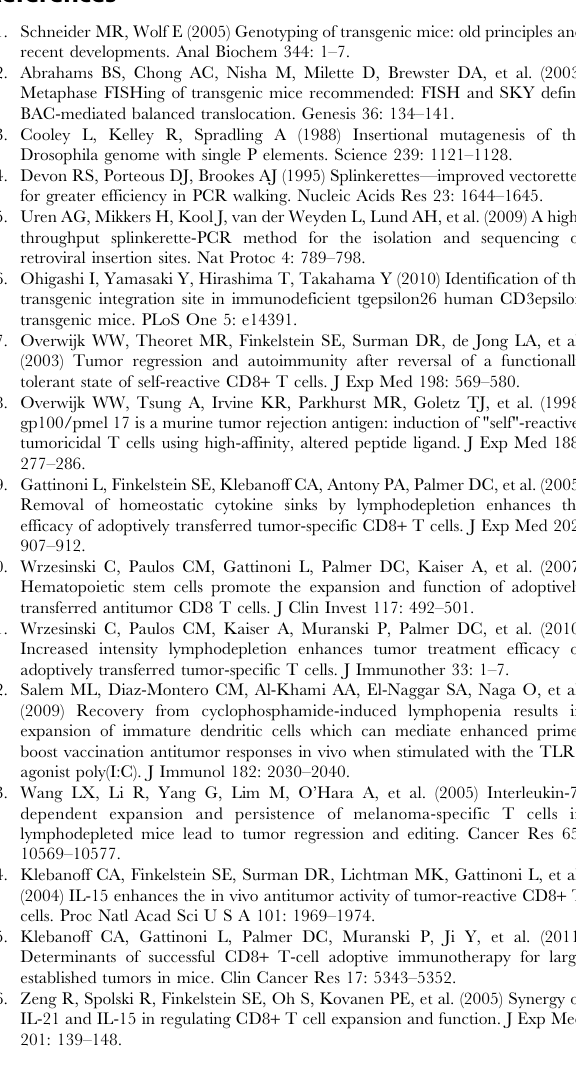
Figure S1 Diagrams of original constructs for generat- ing pmel-1 transgenic animals. (A) Pmel-1 TCR a transgenic vector. The variable region of TCR a were cloned between Xmal and Not I sites. (B) Pmel-1 TCR b transgenic vector. The variable region of TCR b were cloned between Xho I and Sac II sites.